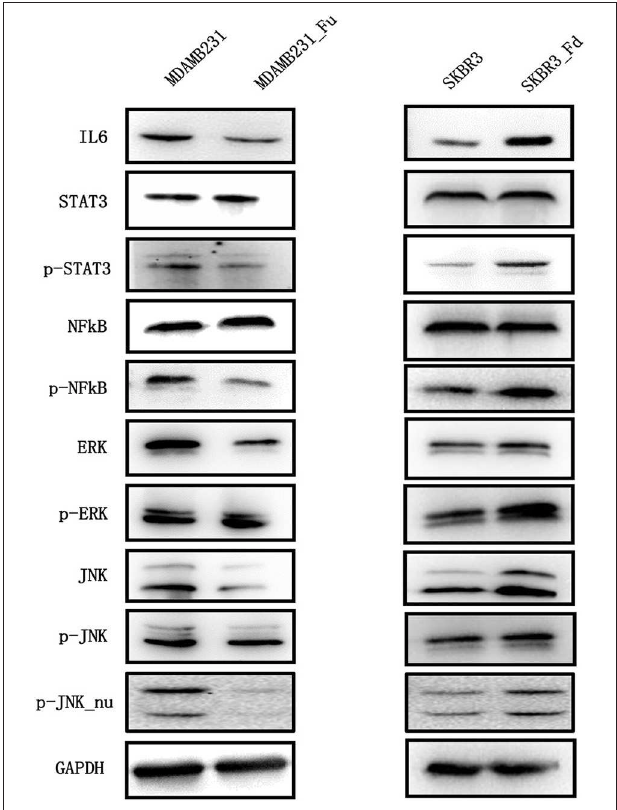
FIGURE 6 | The expression of key proteins of the IL6/STAT3, NFkB, MAPK/ERK, MAPK/JNK pathways in breast cancer cells before and after modulating FA2H expression. “Fd” and “Fu” each represents down- and up-ward gene expression regulation, “ p ” means phorsphoralation.